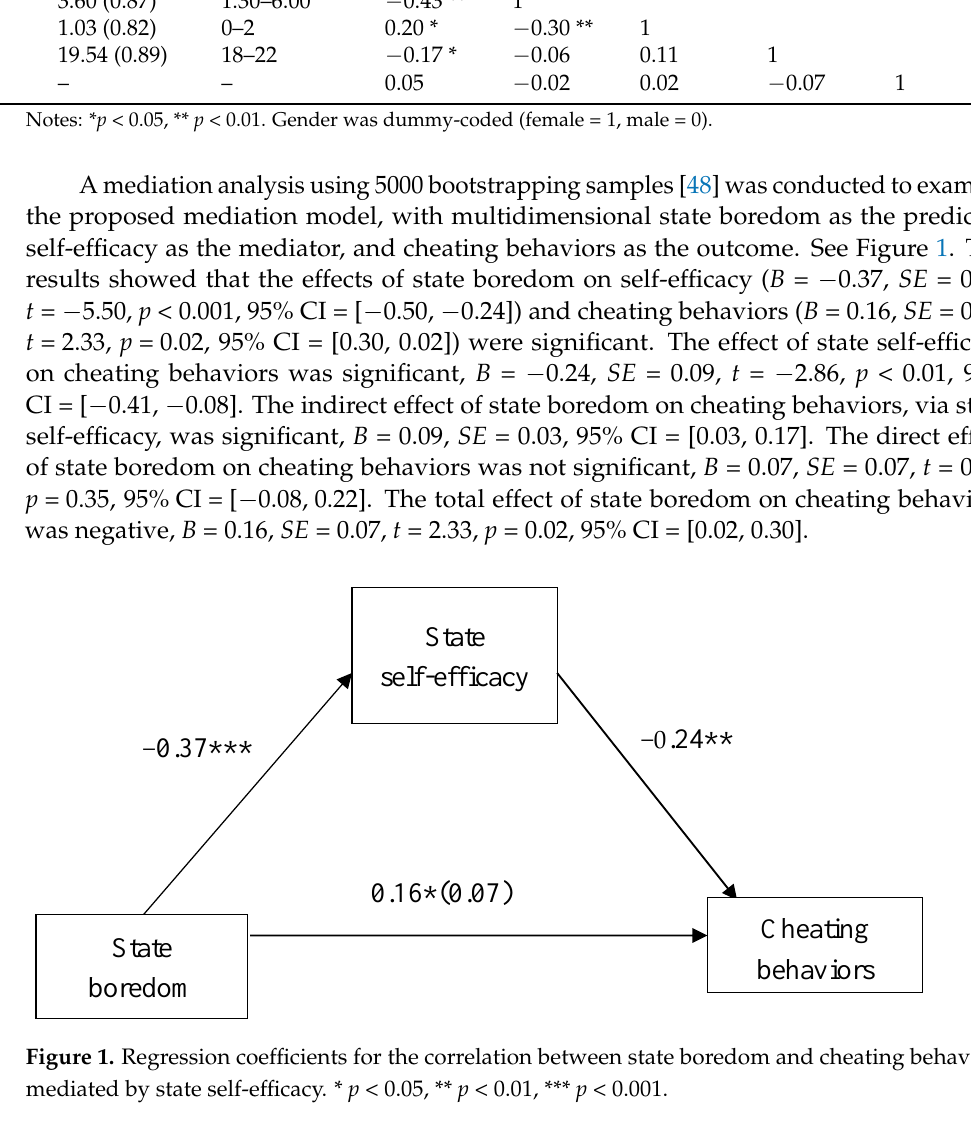
Table 3. Pearson’s correlations of all variables in Study 2 ( N = 139).